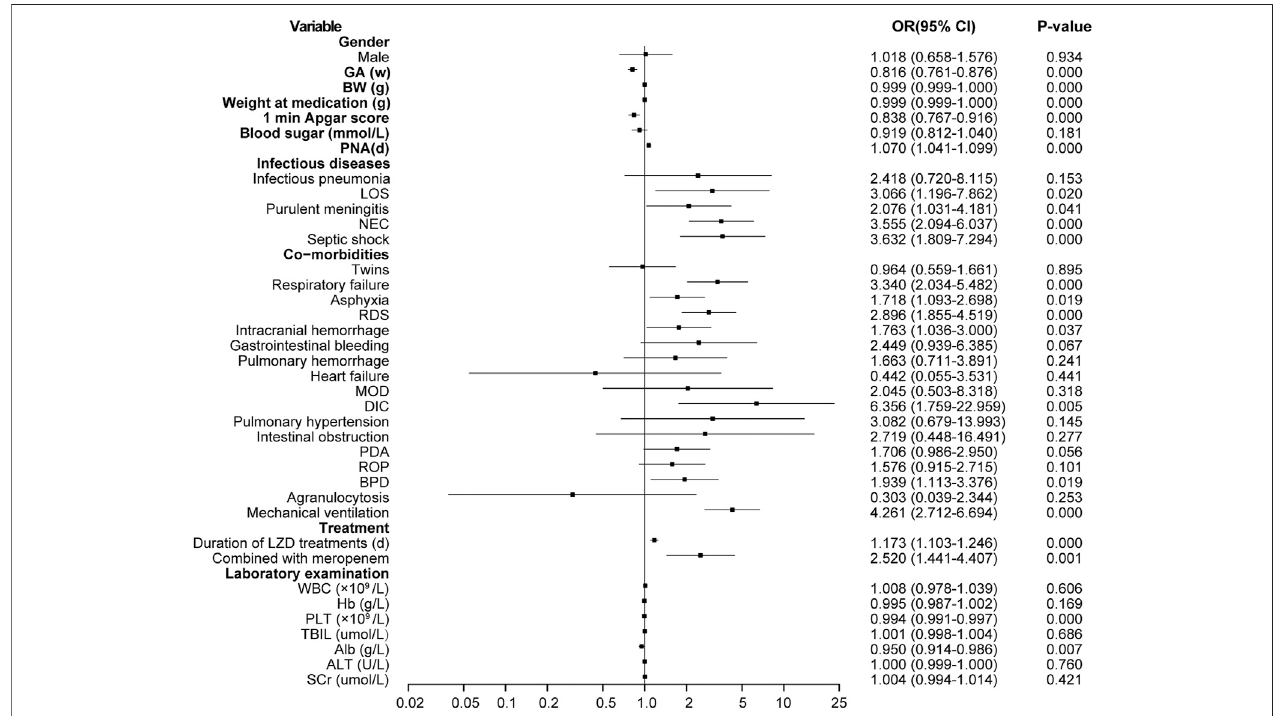
FIGURE 3 | Results of thrombocytopenia risk factors screened by single factor logistic regression analysis. LZD, linezolid; LIT, LZD-induced thrombocytopenia; Non-LIT, non-LZD-induced thrombocytopenia; BW, birth weight; GA, gestational age; PNA, postnatal age; OR, odds ratio; LOS, late-onset sepsis; NEC, neonatal necrotizing enterocolitis; RDS, respiratory distress syndrome; MOD, multi-organ damage; DIC, disseminated intravascular coagulation; PDA, patent ductus arteriosus; ROP,retinopathy ofprematurity; BPD, bronchopulmonary dysplasia; WBC, whiteblood cell; Hb, hemoglobin; PLT, platelet; TBIL, totalbilirubin; Alb, albumin;ALT, alanine aminotransferase; SCr, serum